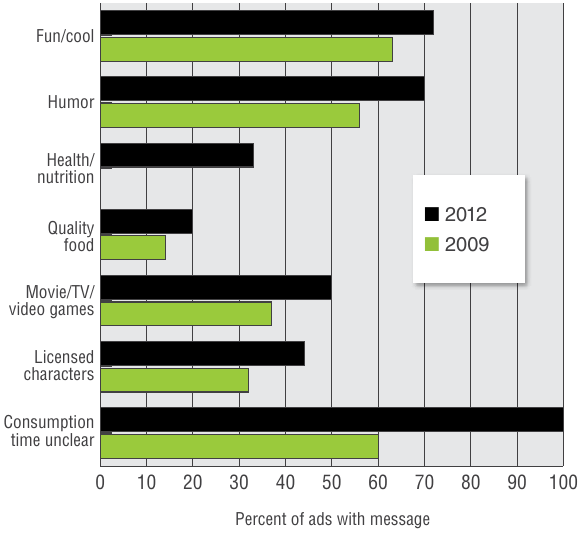
Figure 10. Messages in advertising for kids’ meals on children’s TV networks